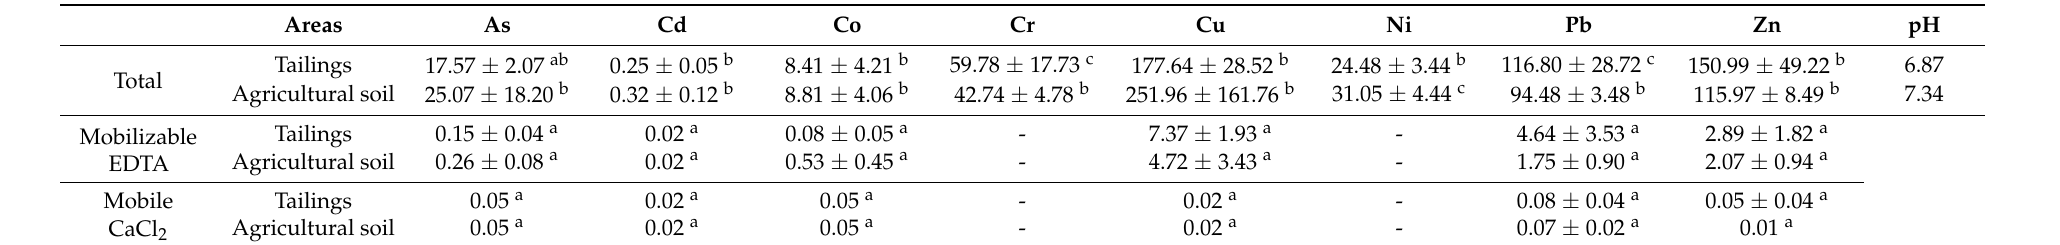
Table 1. Total concentrations and mobile and mobilizable fractions of metals and metalloids in the rhizospheric soils (mean ± SD, for three repetitions) in mg/kg and